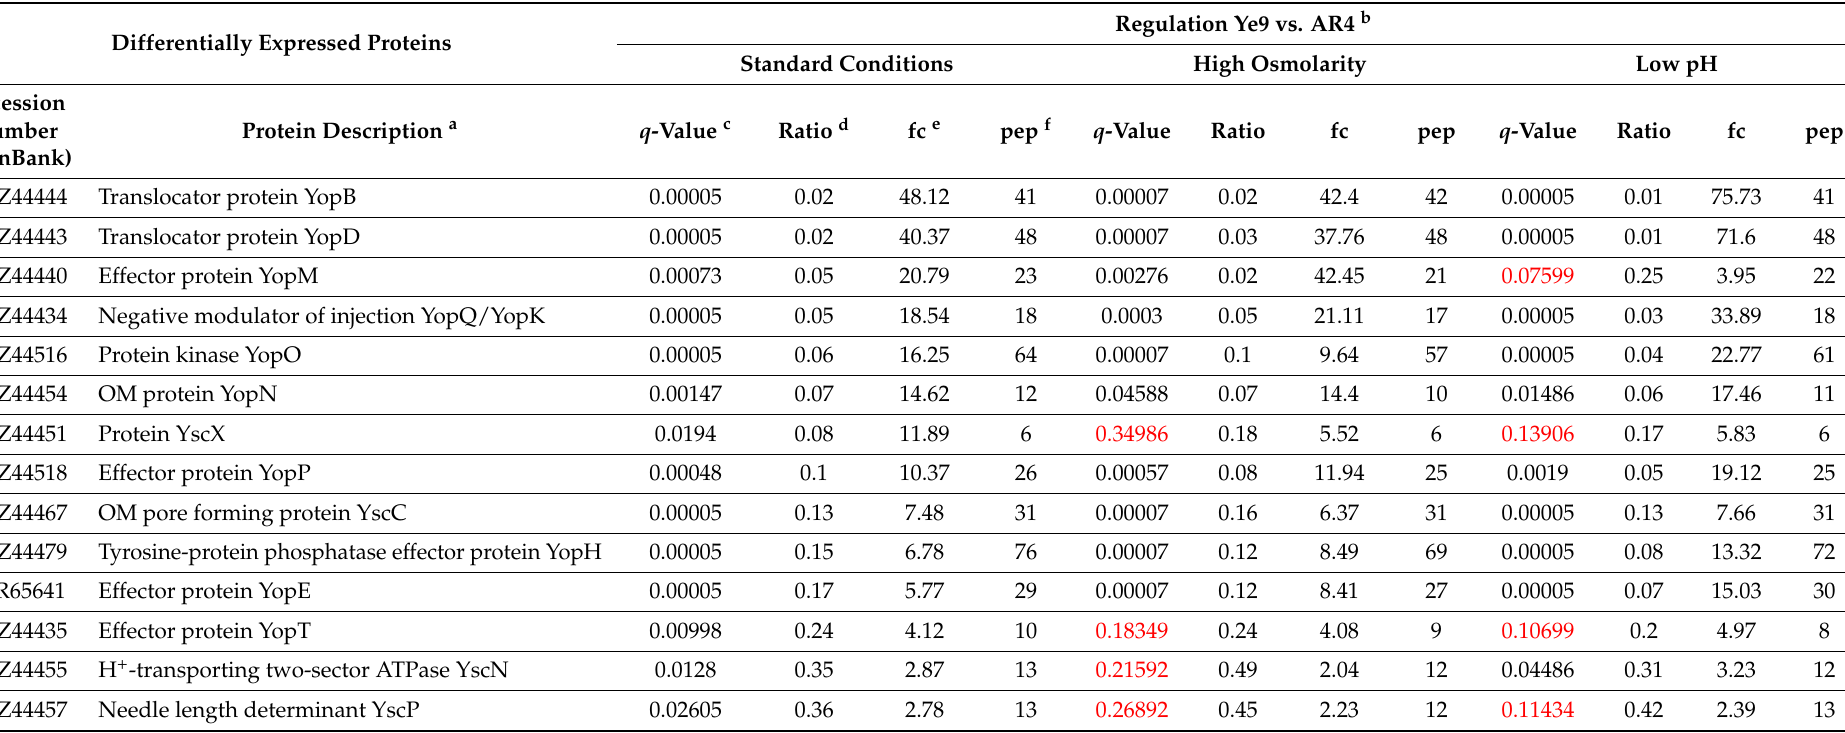
Ysc-Yop T3SS proteins produced by Y . enterocolitica wild-type strain Ye9 and isogenic ompR mutant AR4 grown at 37 ◦ C under different physicochemical